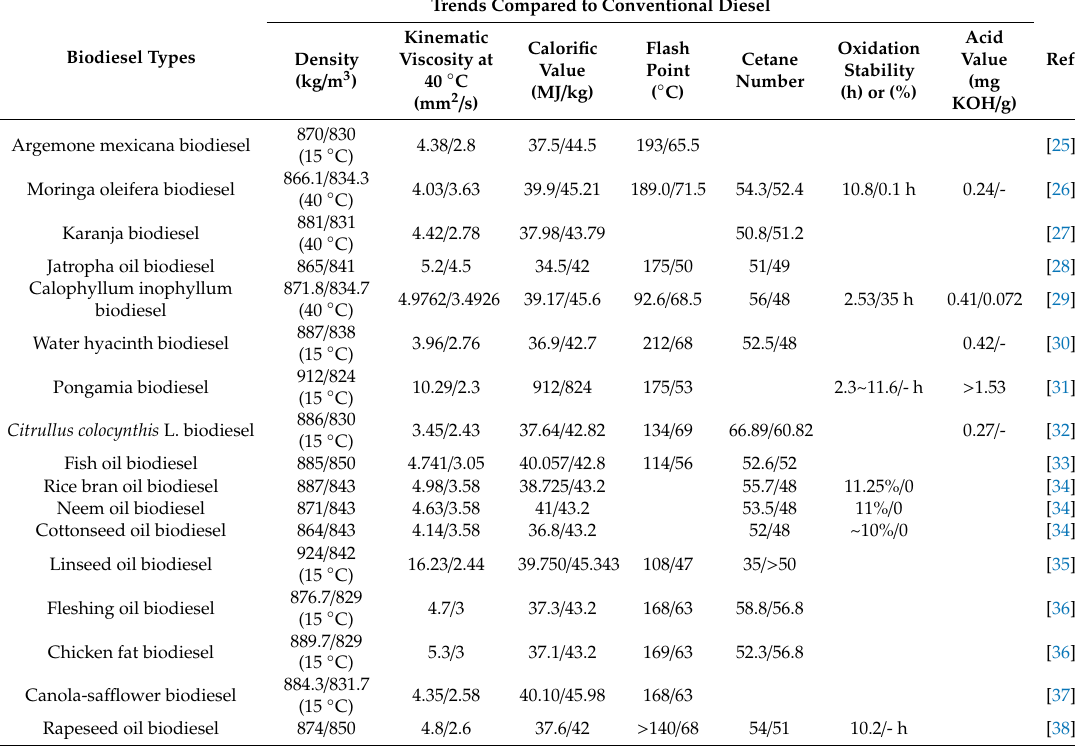
Table 1. Comparison of physicochemical characteristics of biodiesel and fossil diesel (biodiesel / fossil